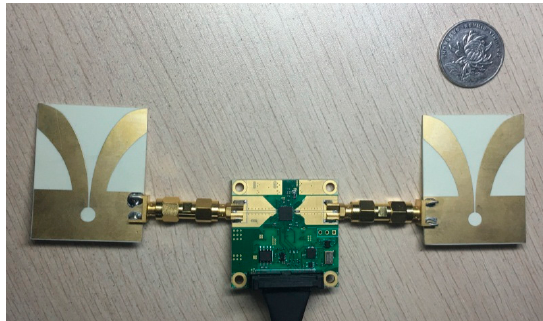
Figure 8. IR-UWB radar system.